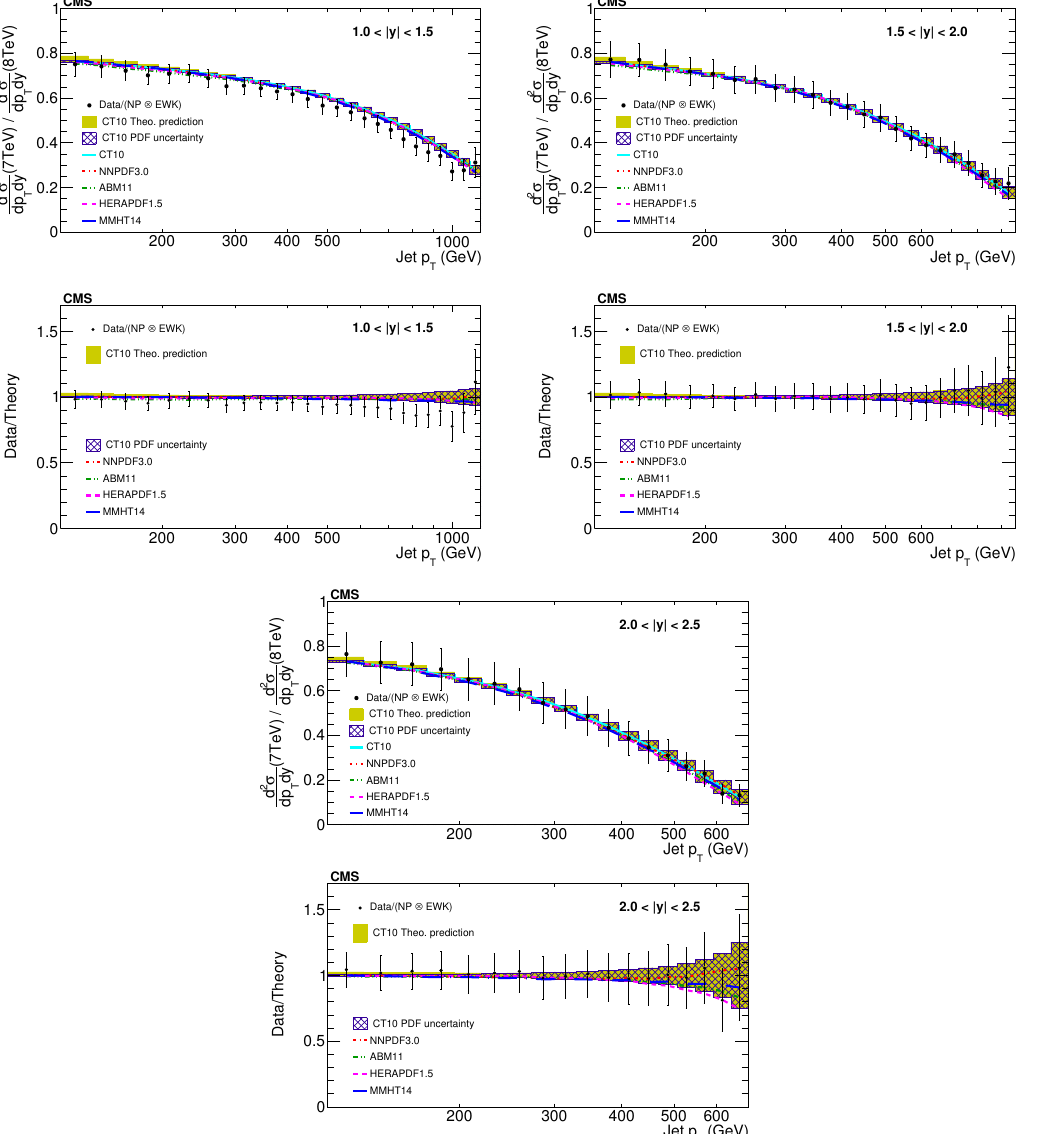
p s = 7 and 8 TeV shown as